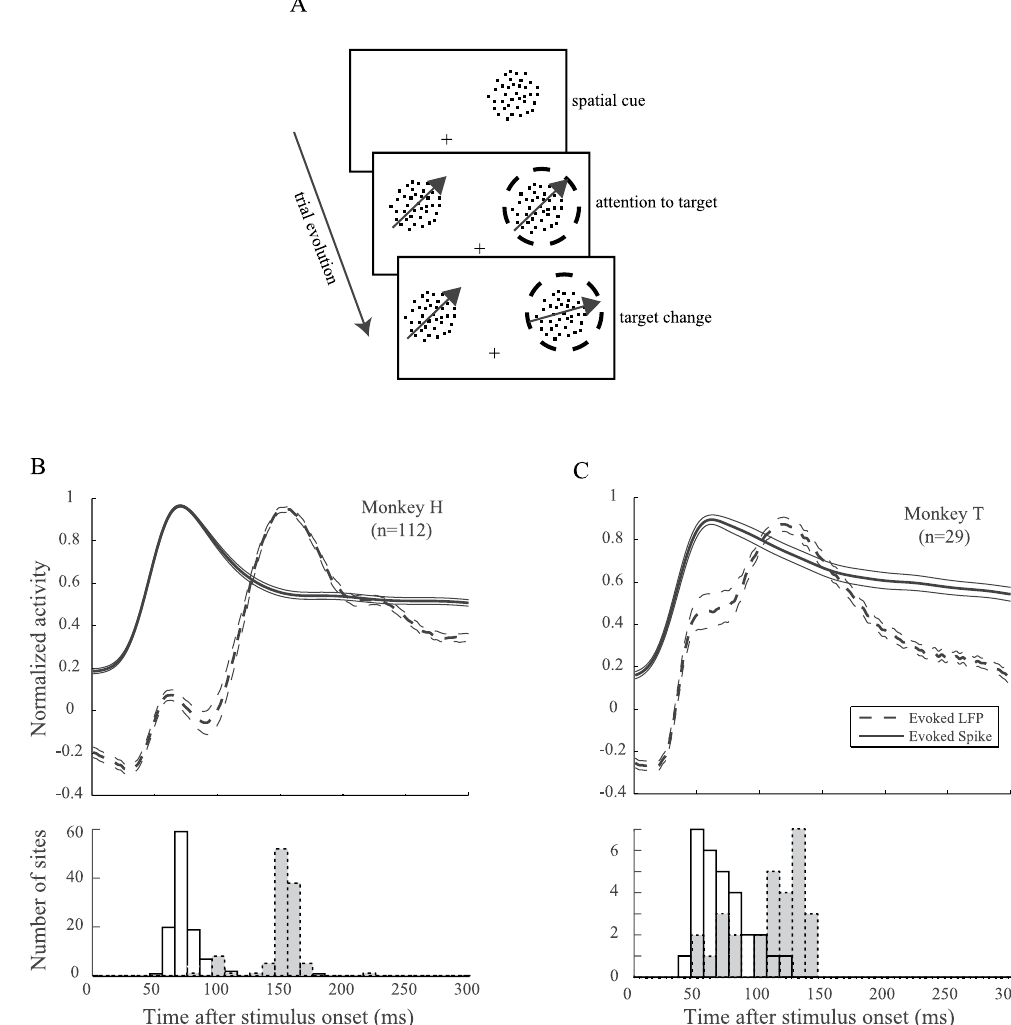
Figure 1. Task design and stimulus-evoked spiking/LFP activity. Panel A shows the behavioral paradigm. The monkeys had to foveate a central fixation point (shown as a cross). Shortly thereafter, an RDP cued the position of the upcoming target stimulus. The monkeys had to detect a subtle change in the color/motion direction of the target RDP (indicated by a dashed circle here) by releasing the lever. Panels B and C present data recorded from each of the monkeys and “n” represents the number of recording sites for each animal. Both spiking activities and LFPs are normalized to the maximum value of each recording site across trials. Standard errors reflect standard error of the mean (SEM). Note that we inversed all LFP values before normalization in order to present the activity relative to the intracellular space (see Materials & Methods for